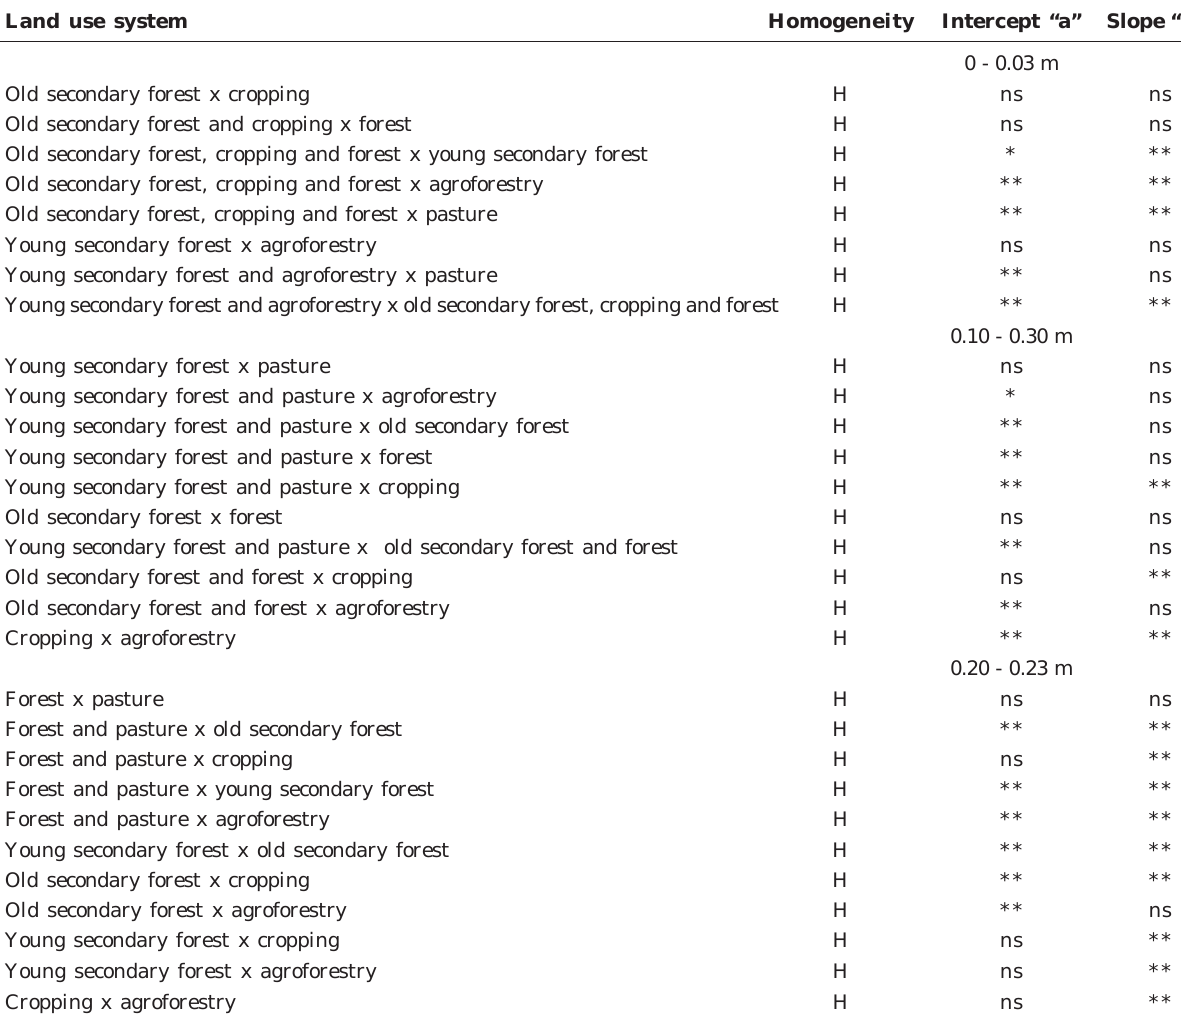
Table 2. Comparison of the load bearing capacity models (1) [ σσσσσ p = 10 (a + b θθθθθ ) ] of a Cambisol samples for different